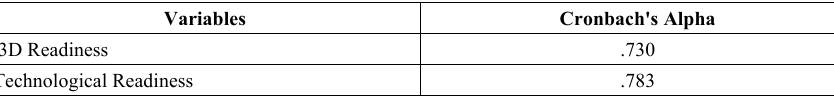
Table 2. Showing the reliability of the